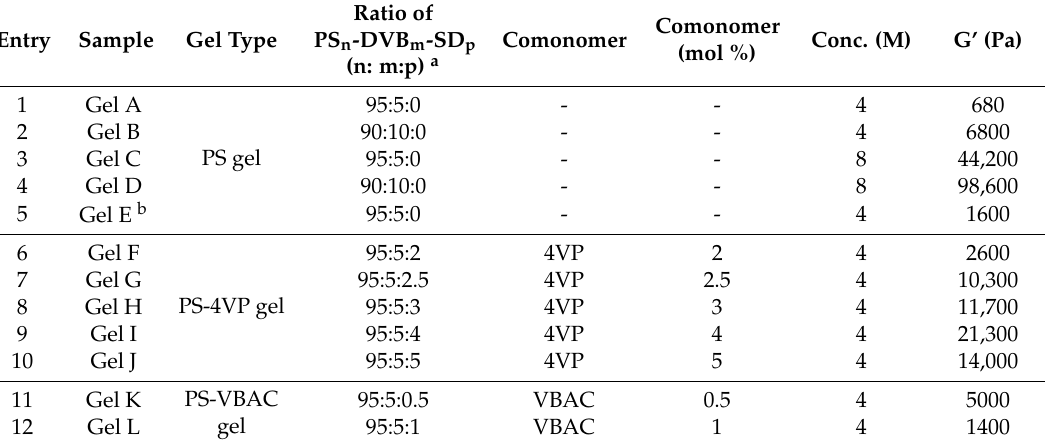
Table 1. Gel preparation and elastic modulus (G’).